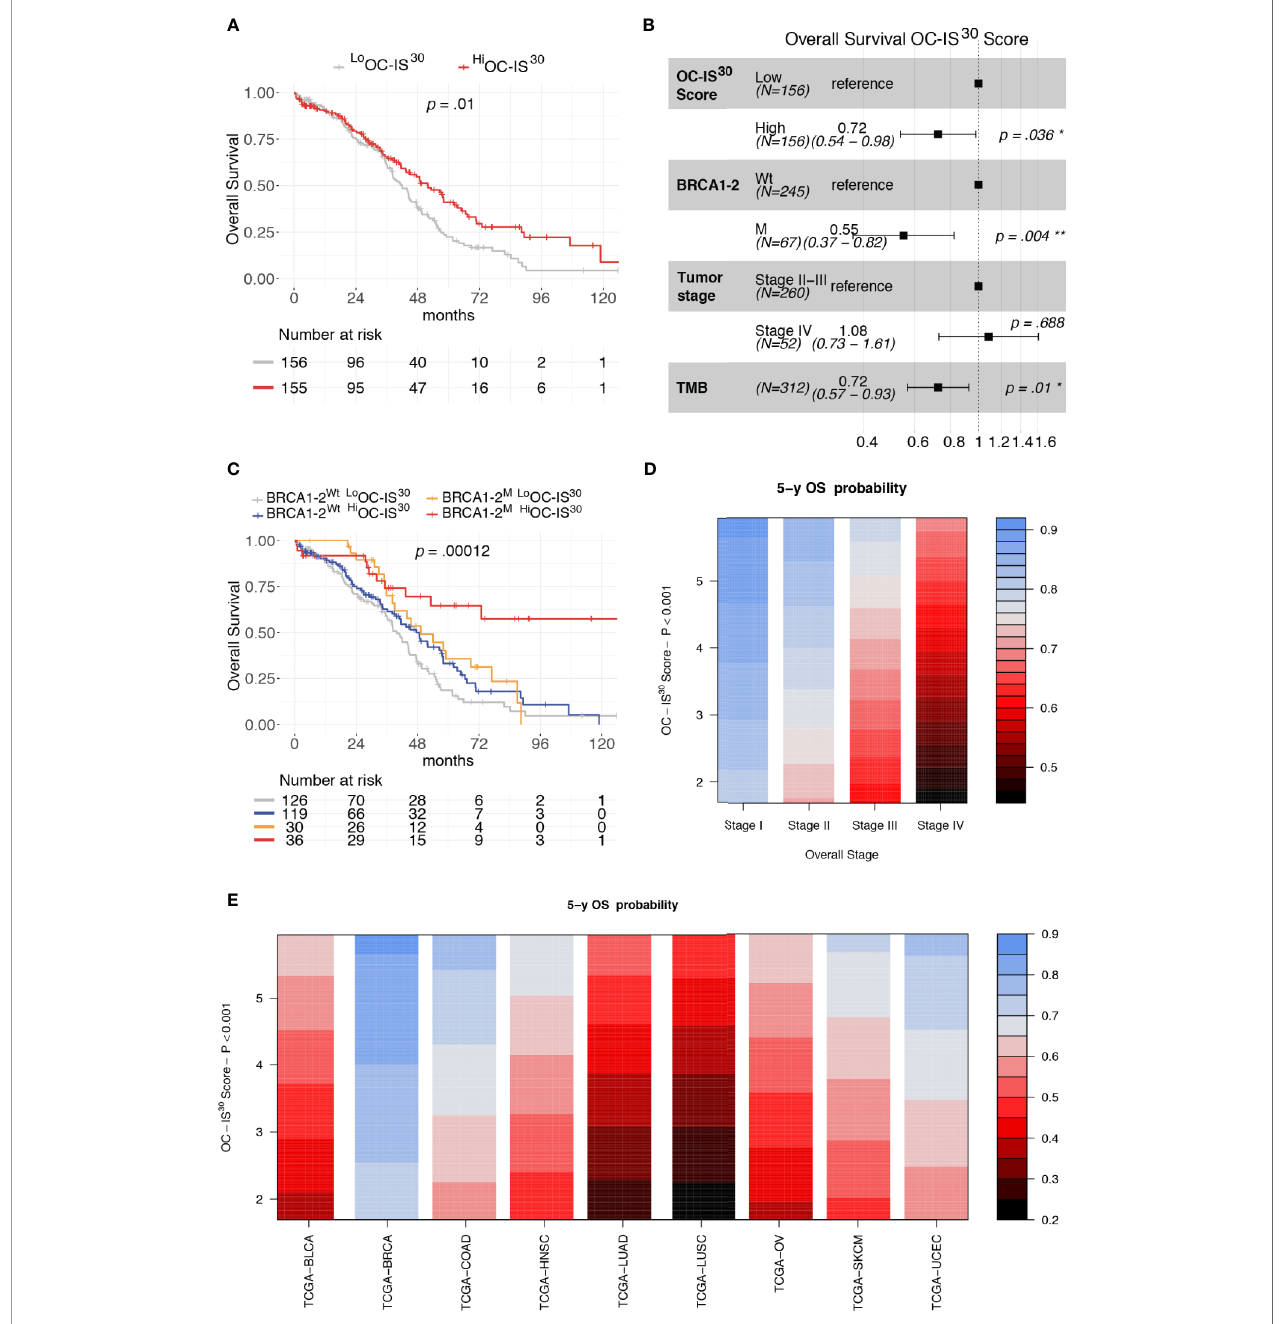
FIGURE 4 | Prognostic signi fi cance of OC-IS 30 in the TCGA datasets. Prognostic signi fi cance of Hi OC-IS 30 group by univariable (A) and multivariable (B) overall survival analysis; Kaplan – Meier curves of the OC-IS 30 status combined with BRCA1 and BRCA2 mutational status (C) . Contour plots from a multivariable Cox model analyzing samples from 9 TCGA datasets (N = 4,496) including the Overall Stage, the OC-IS 30 Score [weighted log(normalized gene expression+1) applying the coef fi cients de fi ning the OC-IS 30 signature ( Figure 3B )] and the tumor site showing the signi fi cant, independent and additive favorable prognostic signi fi cance (color gradient) of lower Stage (D) and higher OC-IS 30 score (E) across the different tumor sites. P values estimated by log-rank test in (C) and by Cox models in (A, B, D, E) . BLCA, Bladder Urothelial Carcinoma; BRCA, Breast invasive carcinoma; COAD, Colon adenocarcinoma; HNSC, Head and Neck squamous cell carcinoma; LUAD, Lung adenocarcinoma; LUSC, Lung squamous cell carcinoma; OV, Ovarian serous high grade carcinoma; SKCM, Skin Cutaneous Melanoma; UCEC, Uterine Corpus Endometrial Carcinoma. *P < 0.05; **P <